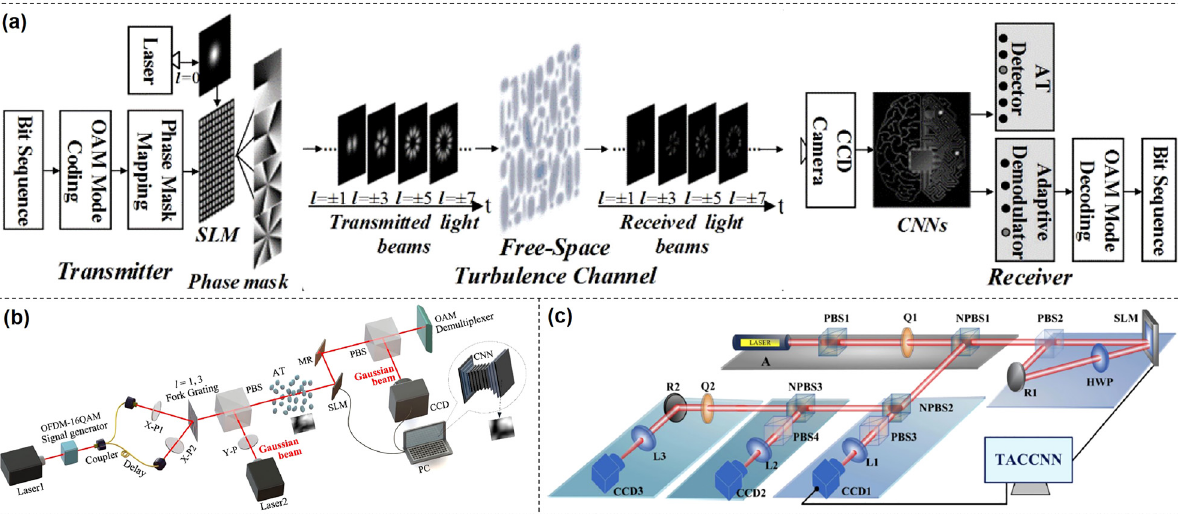
Figure 28: Intelligent spatial mode optical communications. (a) Joint atmospheric turbulence detection and adaptive demodulation technique based on CNN [142]. (b) The system diagram of OAM multiplexing communication link with atmosphere turbulence compensation assisted by the deep learning method [143]. (c) Experimental con fi guration using turbulence aberration correction convolutional neural network (TACCNN) for vector beam communications [144]. Reprint permission obtained from [142 –